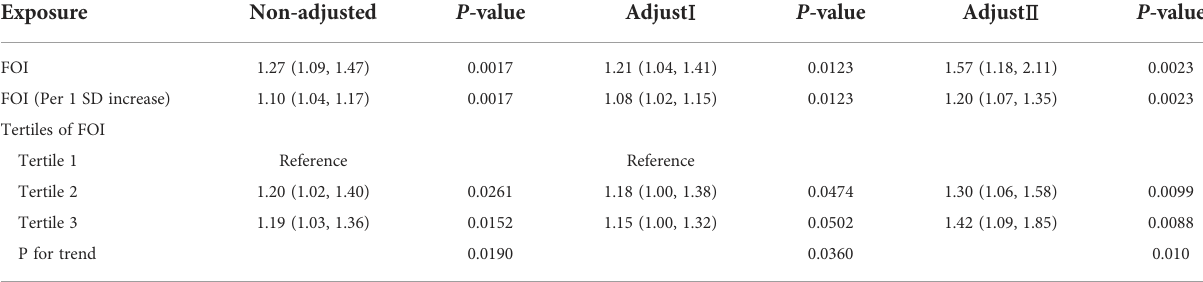
TABLE 3 Multivariate logistic regression of FOI for